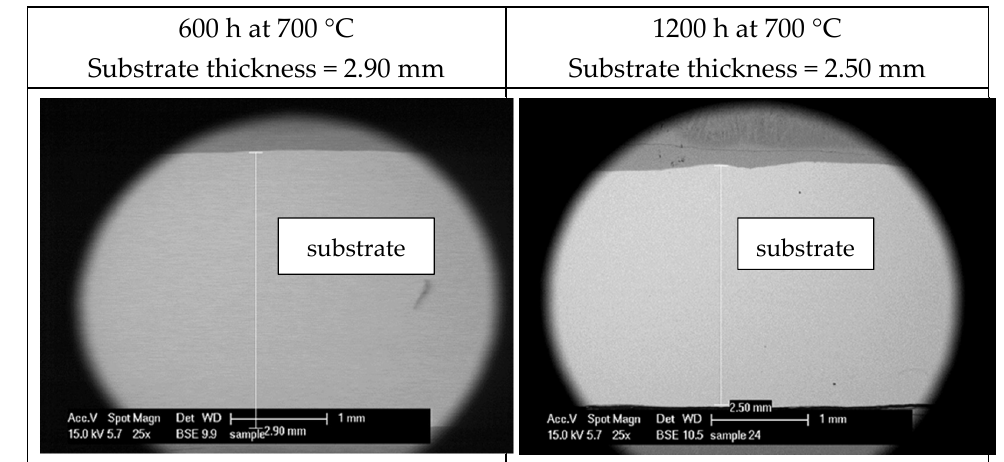
Figure A3. Example—SEM micrograph after aging (TiAlN coating—initial substrate thickness = 3, 7 mm).